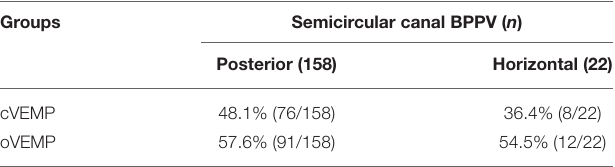
TABLE 6 | Comparison of abnormal rates of vestibular-evoked myogenic potentials (VEMPs) between two types of benign paroxysmal positional vertigo